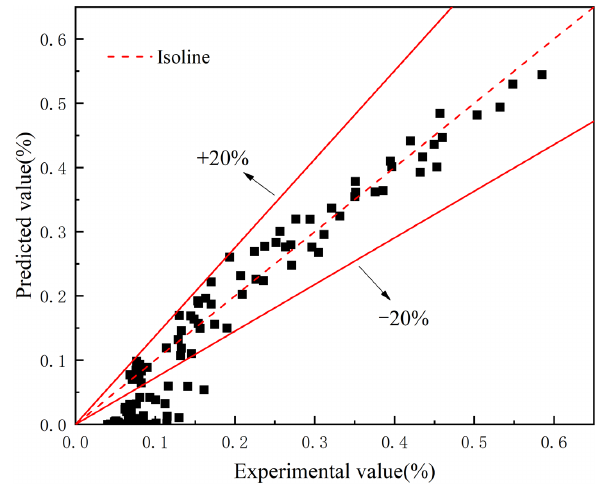
Figure 11. Relative error analysis of the prediction model.